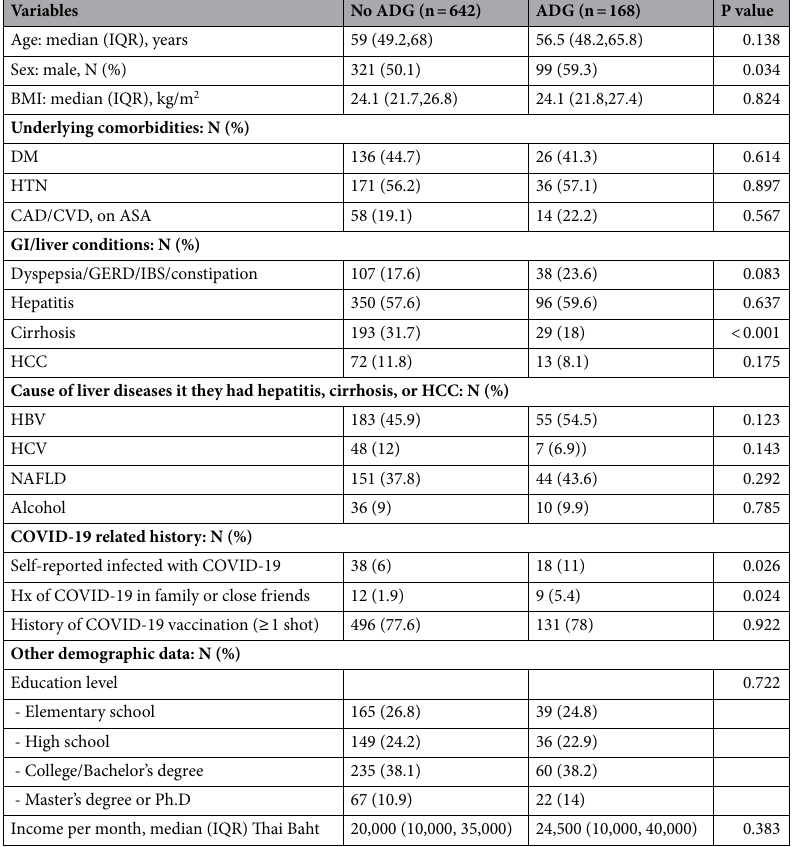
Table 1. Baseline clinical characteristics between control group and ADG group in all 810 patients. ADG, andrographolide; ASA, aspirin; BMI, body mass index; CAD/CVD, coronary artery disease/cardiovascular disease; COVID-19, Coronavirus disease 2019; DM, diabetes mellitus; GERD, gastroesophageal reflux disease; GI, gastrointestinal; IBS, irritable bowel syndrome; HBV, hepatitis B virus; HCC, hepatocellular carcinoma; HCV, hepatitis C virus; HTN, hypertension; IQR, interquartile range; N, number of patients; NAFLD, non- alcoholic fatty liver disease; Ph.D., Doctor of